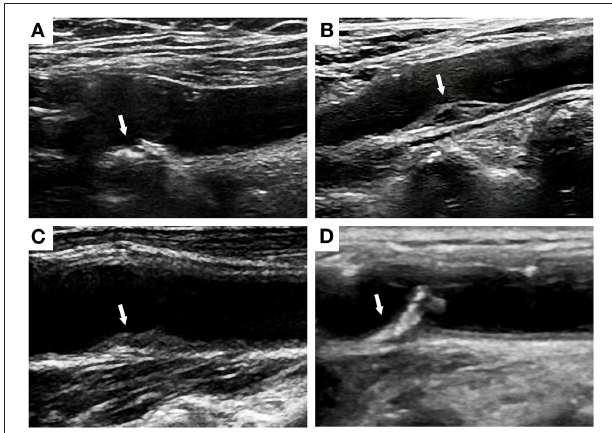
FIGURE 2 | Ultrasound images of hyper-echo (A) , low-echo (B) , mixed-echo (C) , and ulcer plaques (D) at the carotid